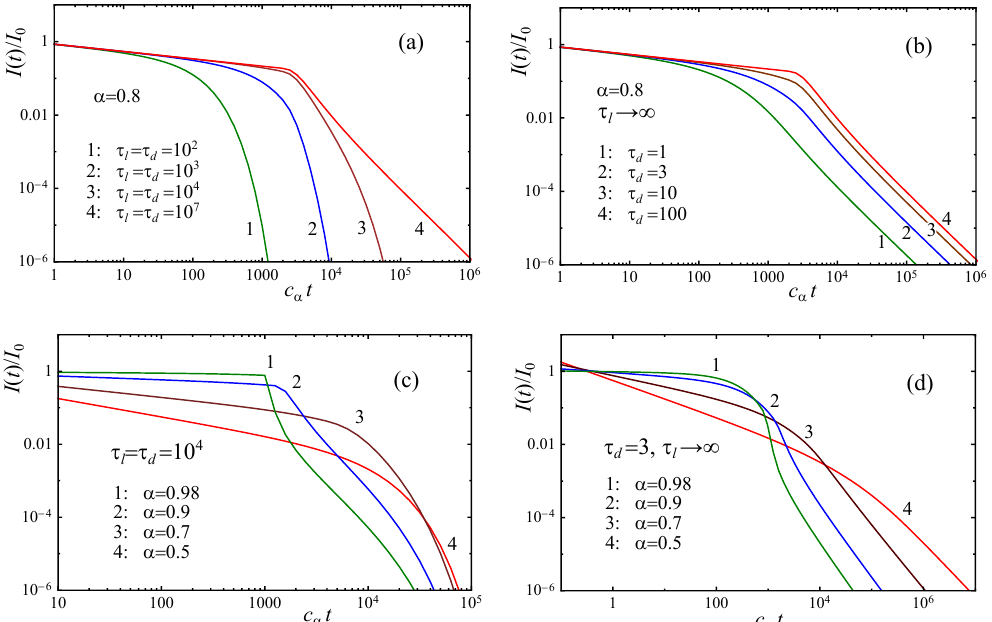
Figure 2. Transient photocurrent I ( t ) corresponding to the Laplace transform (30) for different values of parameters α , τ l and τ d indicated in figure. Parameters τ l and τ d are given in units of c − 1 α , ω 0 = 100 c α , t 0 = 10 c − 1 α , I 0 = qn 0 / ( ω 0 t 0 ) . Recombination via localized states for α < 1 leads to the exponential truncation of a transient current tail ( a ). Recombination via delocalized states only does not lead to a change in the power law exponents of I ( t ) before and after the break, but reduces time of flight t T and smooths out the break itself ( b ). Effect of charge leakage on transient currents depends on dispersion parameter α and ratio of τ l , τ d and t T ( c ). Variation of α for fixed τ d = 3 in units of c − 1 α and τ l → ∞ confirms the indicated effect of leakage via delocalized states ( d